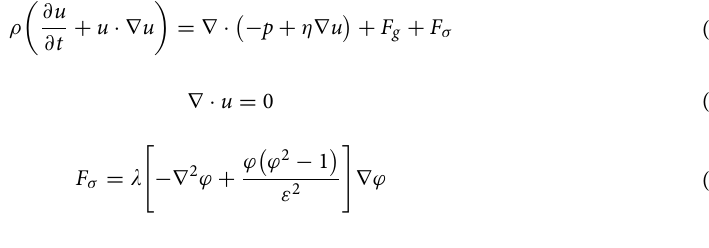
Images taken from the front side and top side over time are shown in Fig. 2 21 . The bottom glass is hydrophilic, while the top surface is hydrophobic. As a result, the bottom contact area is stable, but the top area periodically changes during the oscillation. There is a difference between the top contact area and the bottom contact area because of the gravity effect and the lower capillarity of the top plate. In the oscillating process, the bottom contact area keeps the initial state all the time because of the pinning effect caused by the hydrophilicity of bottom plate. On the other hand, the top contact area changes periodically as the bottom plate moves up and down because the top plate was hydrophobically coated with PTFE. The size of a liquid drop is 40 μl, the vibration frequency is 10 Hz, and the amplitudes are 0.50, 0.75 and 0.90 mm. To investigate the effect of the glycerol mixture when it used as a working fluid, experiments were done using various concentrations of the glycerol-water mixture of 0 to 80% by weight. Figure 3 shows the viscosity of the glycerol mixture. The viscosity was up to 60 mPa s. As the concentration increases, the liquid bridge attaches more to the plates, and the contact angle decreases as shown in Fig. 3a.